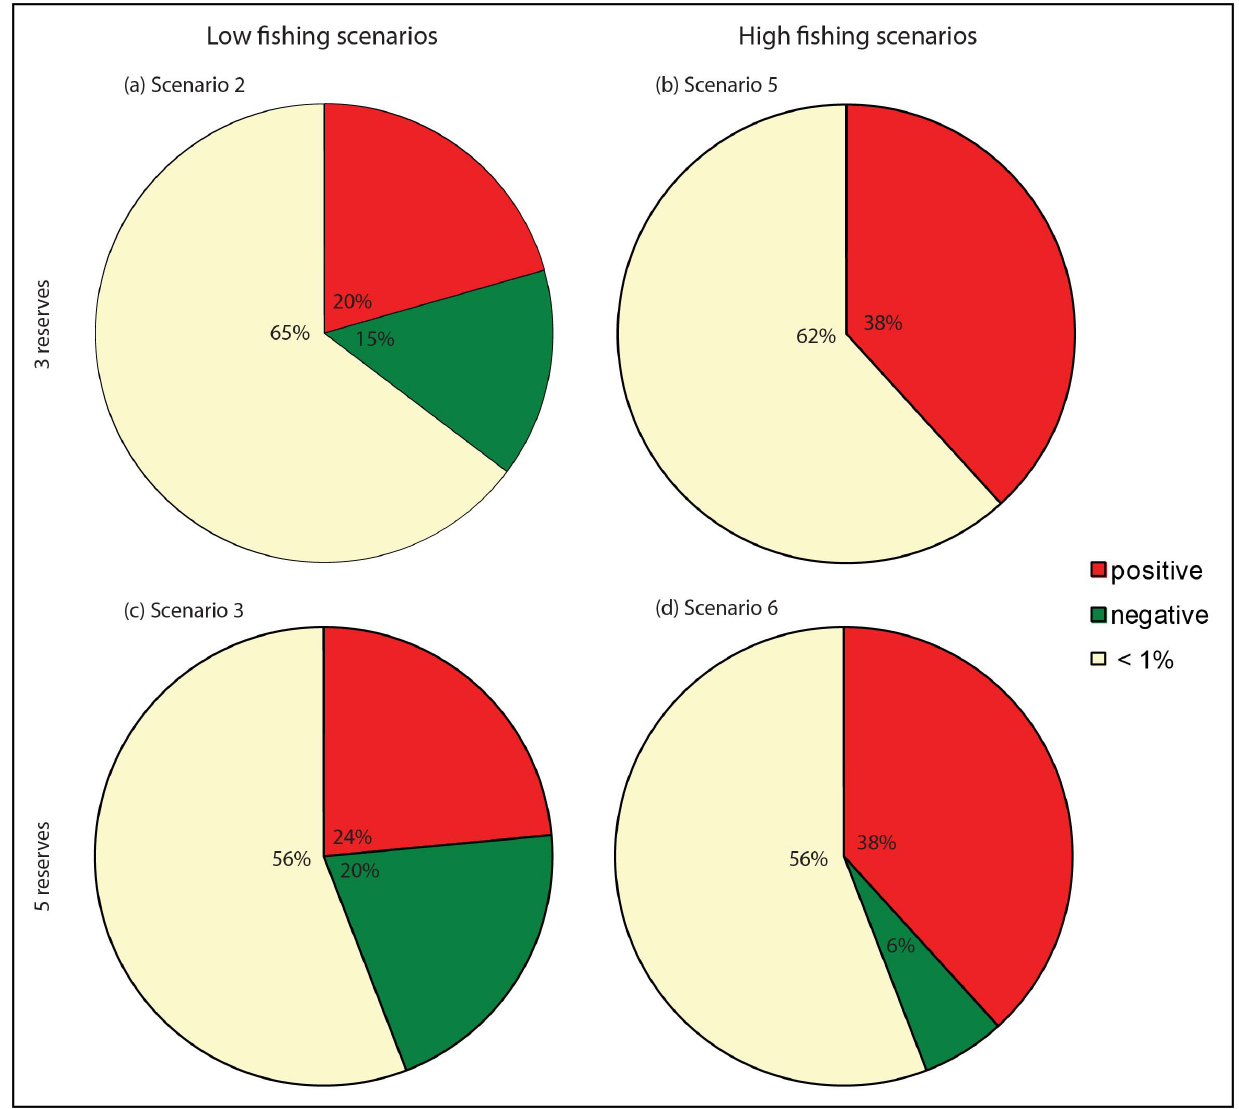
Figure 2. Fraction of all vertebrates, cephalopods and prawns (34 groups) that show an increase, decrease or no significant change in biomass under the four scenarios.